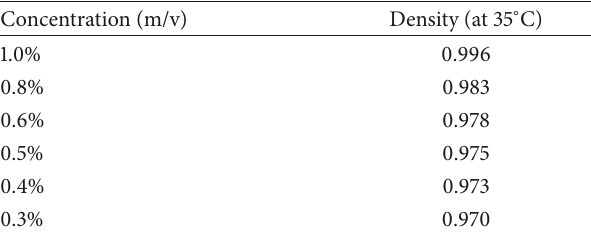
Table 1: Density ( × 10 3 kg/m 3 ) of polyvinyl alcohol (PVA) at 35 ∘ C temperature and concentration at 1MHz frequency.